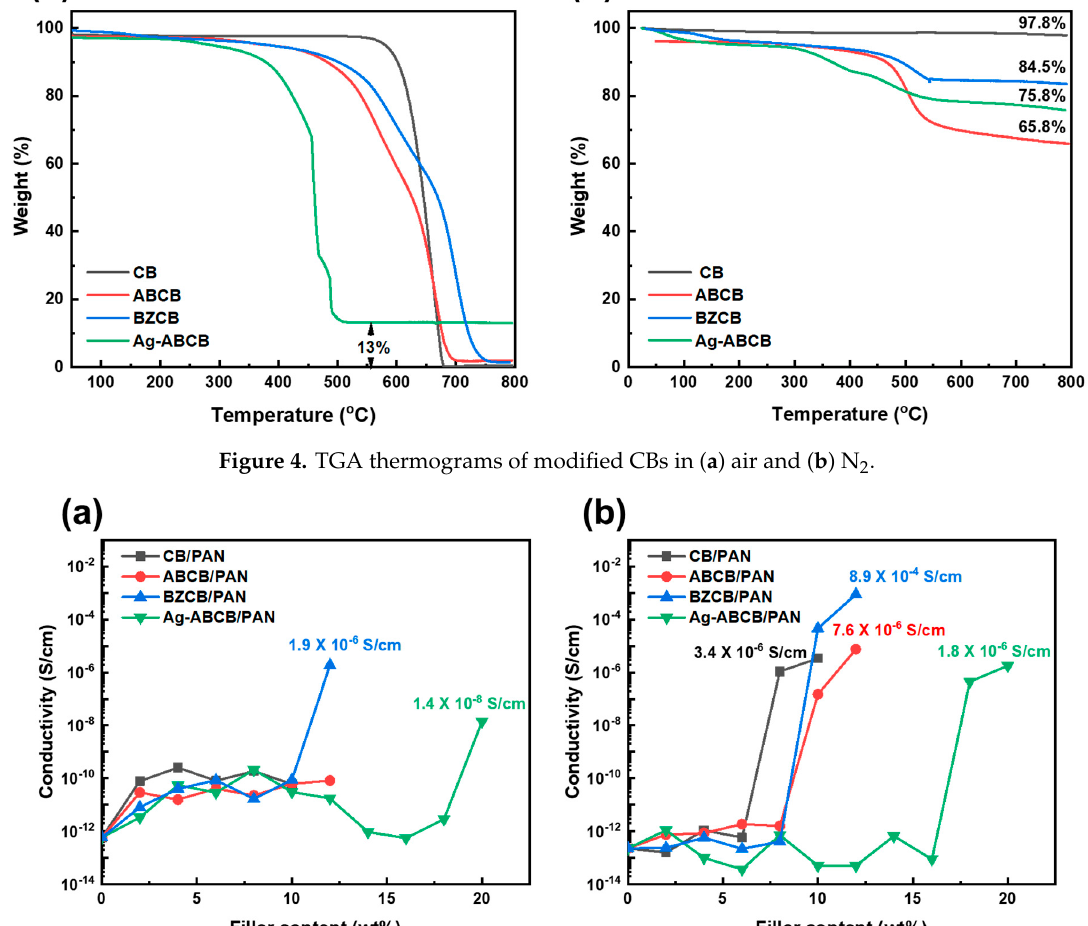
Figure 5. Electrical conductivities of PAN fibers with different contents of CB and modified CBs ( a ) as-spun and ( b ) annealed fiber.